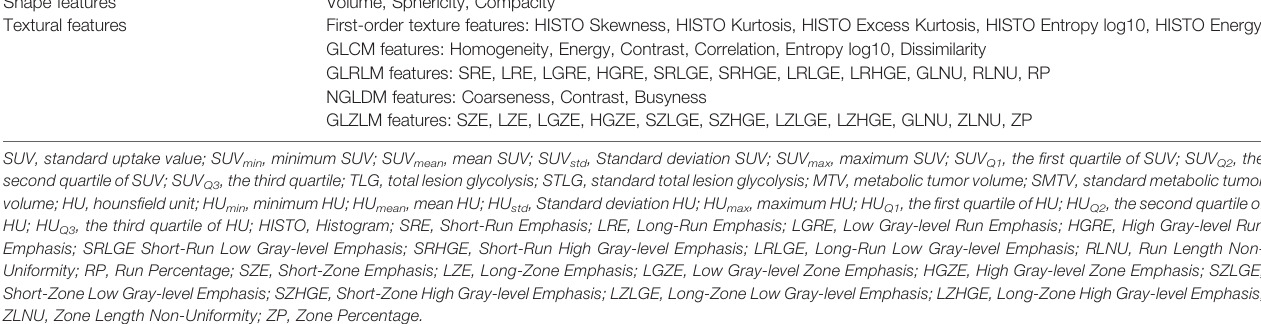
SUV conventional features (PET